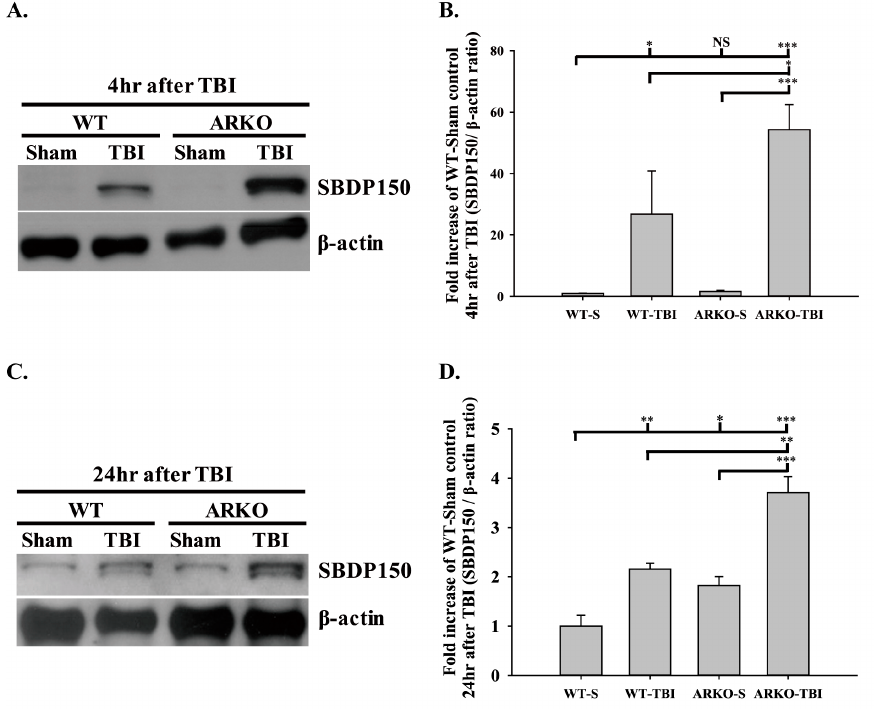
Figure 1. Androgen receptor knockout enhances traumatic brain injury (TBI)-induced necrosis marker spectrin breakdown product 150 (SBDP150) expression after brain injury in mice. Protein out (ARKO) mice brain tissue after TBI, using Western blot technology. SBDP150 expression ( A ) and the quantitative level ( B ) at 4 h following TBI. TBI enhanced SBDP150 expression of the injured WT brain compared with the WT sham. SBDP150 levels increased significantly in ARKO mice following brain injury than in ARKO sham and WT mice with TBI. ( C ) ARKO mice showed a significantly higher level of SBDP150 expression than WT mice 24 h after TBI. ( D ) Quantitative level of SBDP150 expression at 24 h after TBI. All data are presented as the mean ± standard error. NS, no significant difference; * p < 0.05, ** p < 0.01, *** p < 0.001; n = 3 in each